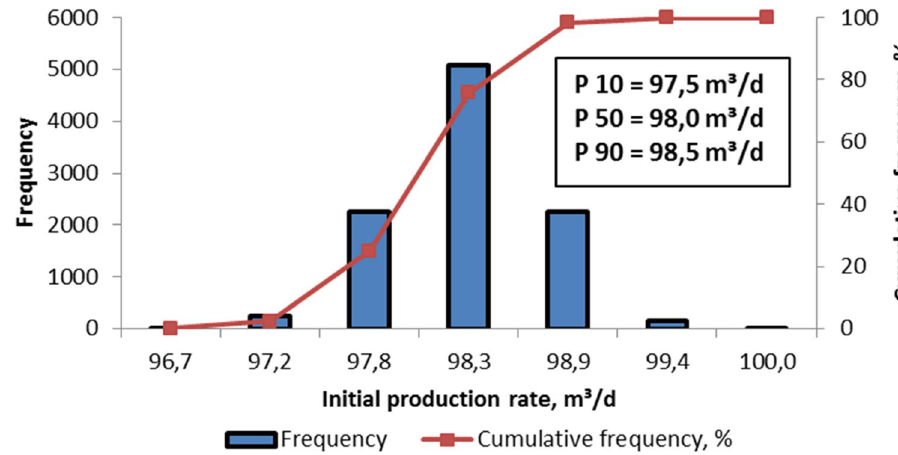
Fig. 15 Results of Monte Carlo simulations showing the initial production rate